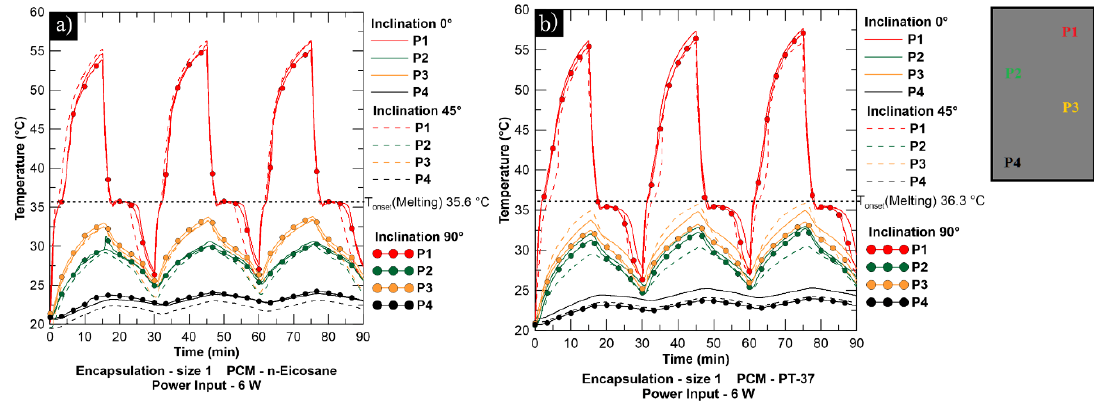
Figure 4. Influence of inclination on PCM melting for intermittent operation at 6 W power input with Size 1 PCM TES Unit: ( a ) n- eicosane and ( b ) PT-37.